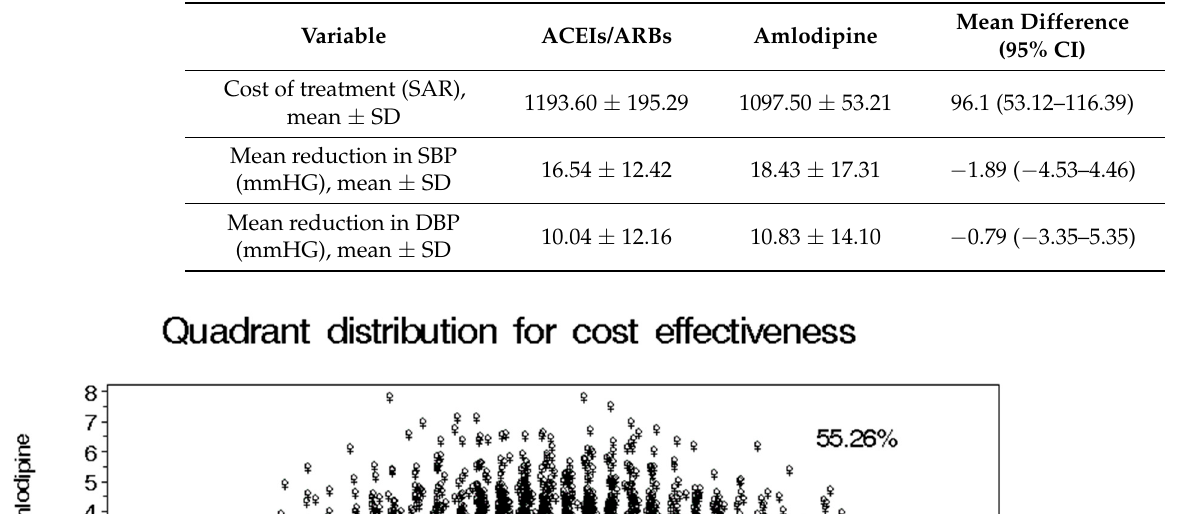
Table 2. The mean reductions in blood pressure (SBP and DBP) and costs of ACEIs/ARBs versus amlodipine.